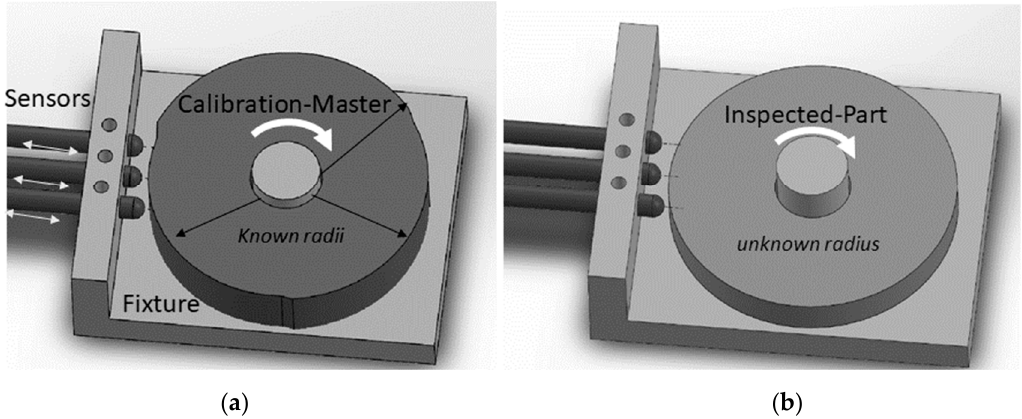
Figure 6. Validation of the TPFK/TPIK algorithms by CAD simulation: ( a ) calibration master assembly. ( b ) Inspected part assembly. Table4. TPIKalgorithmbasedonCADsimulation: displacementsmeasuredbetweensensorcoordinates and the calibration master for two radii by using direct CAD dimensioning tools rounded to n = 6 decimal places.